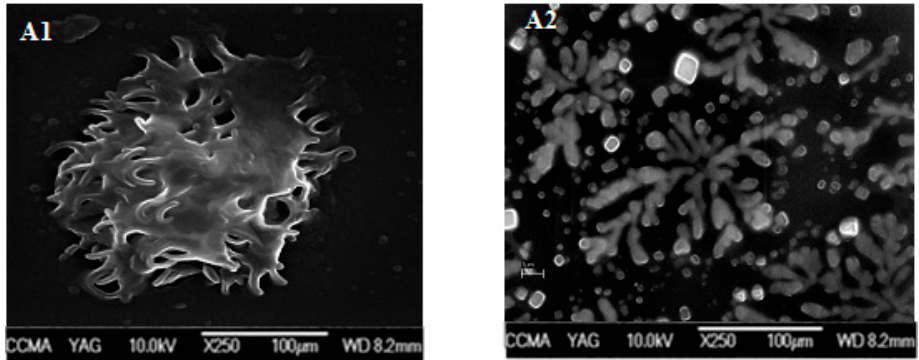
Figure 10. The FEGSEM pictures of two alumina–silica bare-fiber samples of EDF: sample ( A1 ) and sample ( A2 ) drawn at around 1900 °C.